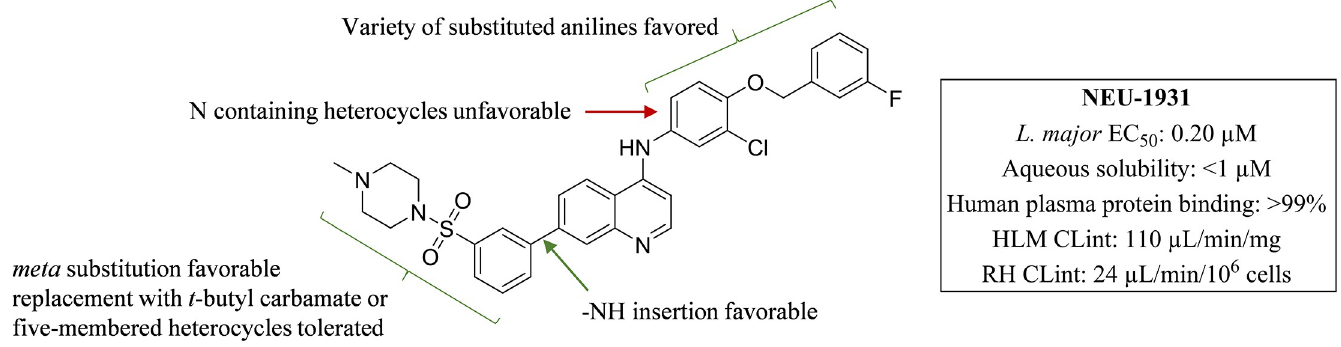
Fig 6. Series SAR summary for anti -L . major activity.